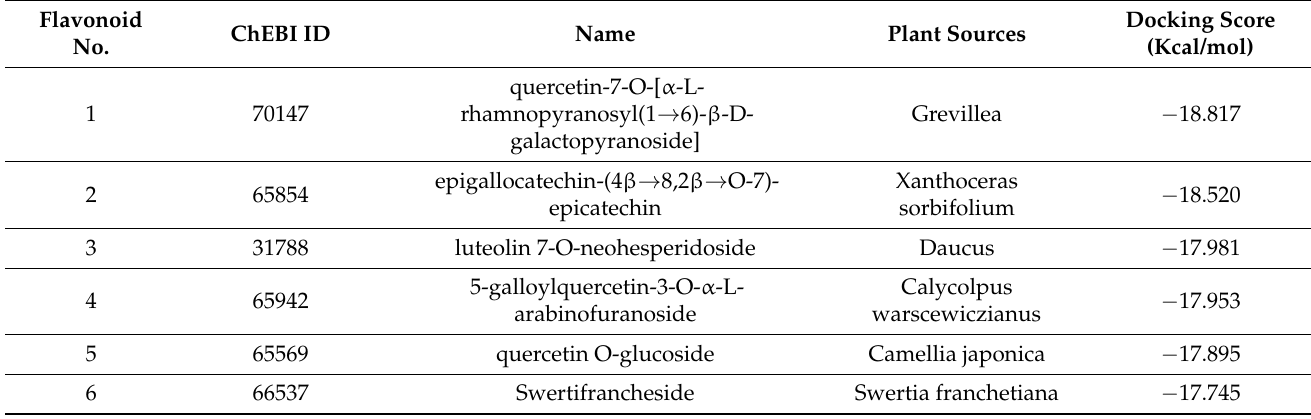
Table 1. Selected flavonoid molecules downloaded from ChEBI (http://www.ebi.ac.uk/chebi/ (accessed on 3 May 2022)) showing maximum docking